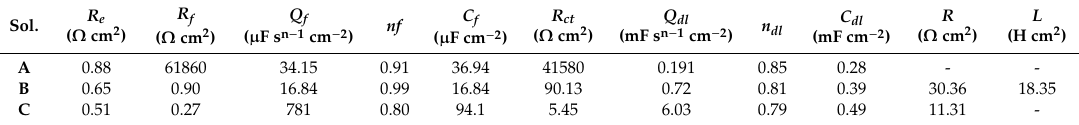
Table 4. Electrochemical parameters of Sn dissolution in di ff erent bromide-containing solutions. Sol.